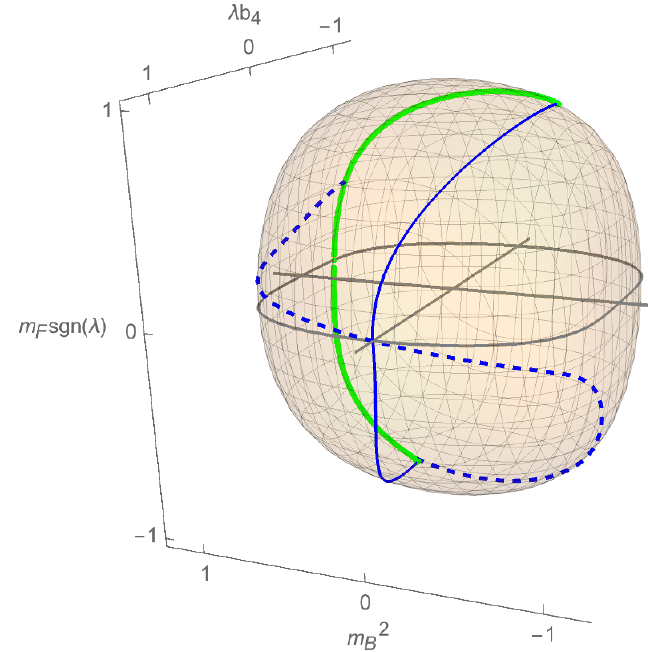
JHEP11(2019)113 Figure 16. The phase diagram ellipsoid of the N = 2 theory for the value j (cid:21) j = 1 . The equator 4 m F = 0 is displayed in gray. There are two solid and two dashed blue lines (one each in the northern hemisphere and one each in the southern hemisphere). The solid blue lines are described by CB conformal theories while the dashed blue lines are RF conformal theories | both correspond to second order phase transitions. The green line is a (cid:12)rst order transition line and lies on the far side of the ellipsoid. The solid blue lines meet the green line at two points (one each on the two hemispheres) | these points are described by the RB conformal (cid:12)eld theory. The solid blue (CB) and dashed blue (RF) lines meet at the point ( m 2 ; (cid:21)b 4 ; m F sgn( (cid:21) )) = (0 ; 1 ; 0) on the equator which B is described by the CB-RF conformal (cid:12)eld